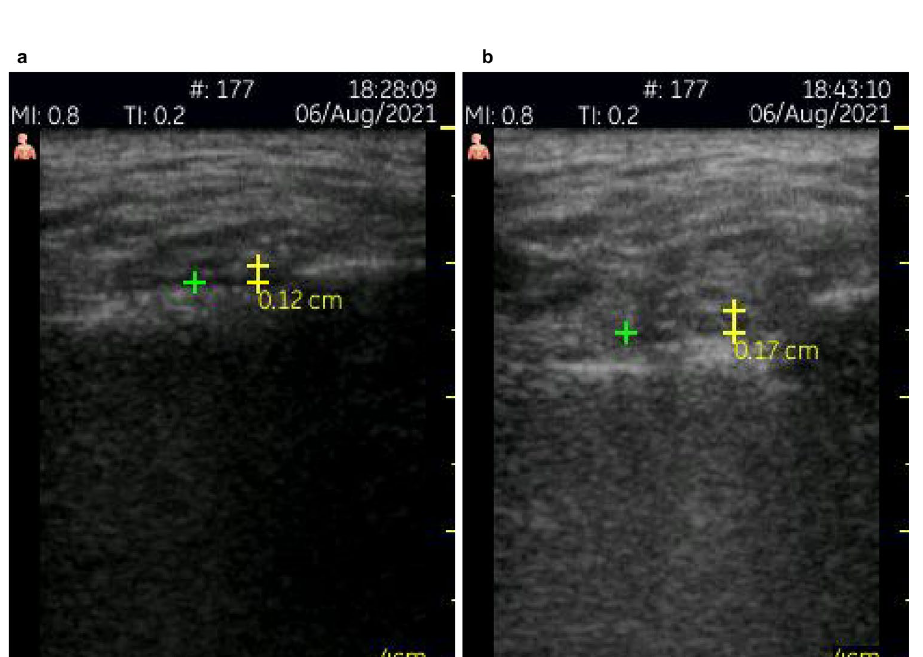
Figure 5. Preoperative ( a ) and postoperative ( b ) measurements of the thickness of the lateral joint